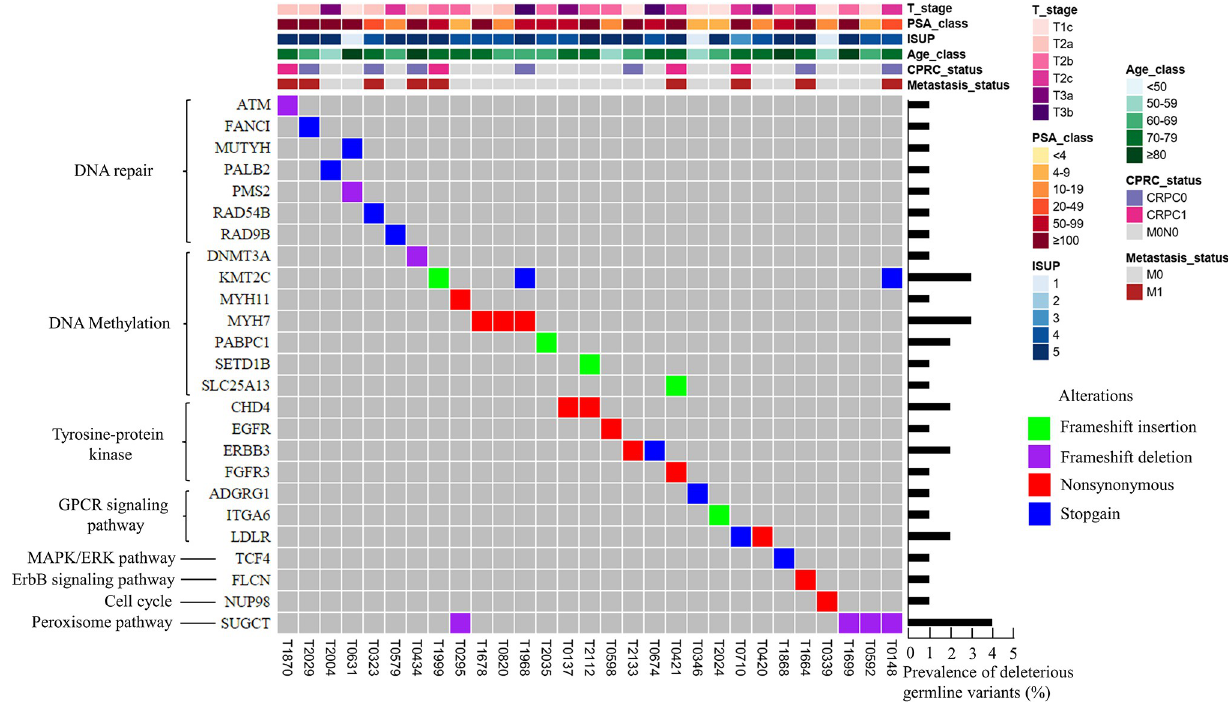
Fig 2. Pathway categorization of deleterious germline variants and clinical characteristics of 29 prostate cancer patients. A total of 36 deleterious variants were identified in 29 patients. Each column corresponds to a patient. The upper section shows the patient’s clinical characteristics [T stage, PSA level, ISUP grade, age, CRPC status and metastasis status]. CRPC1: castration-resistant within one year after starting androgen depletion therapy (ADT); CRPC0: castration-resistant more than one year after starting ADT; M0N0: neither distant metastasis nor regional lymph nodes metastases; M0: no distant metastasis; M1: distant